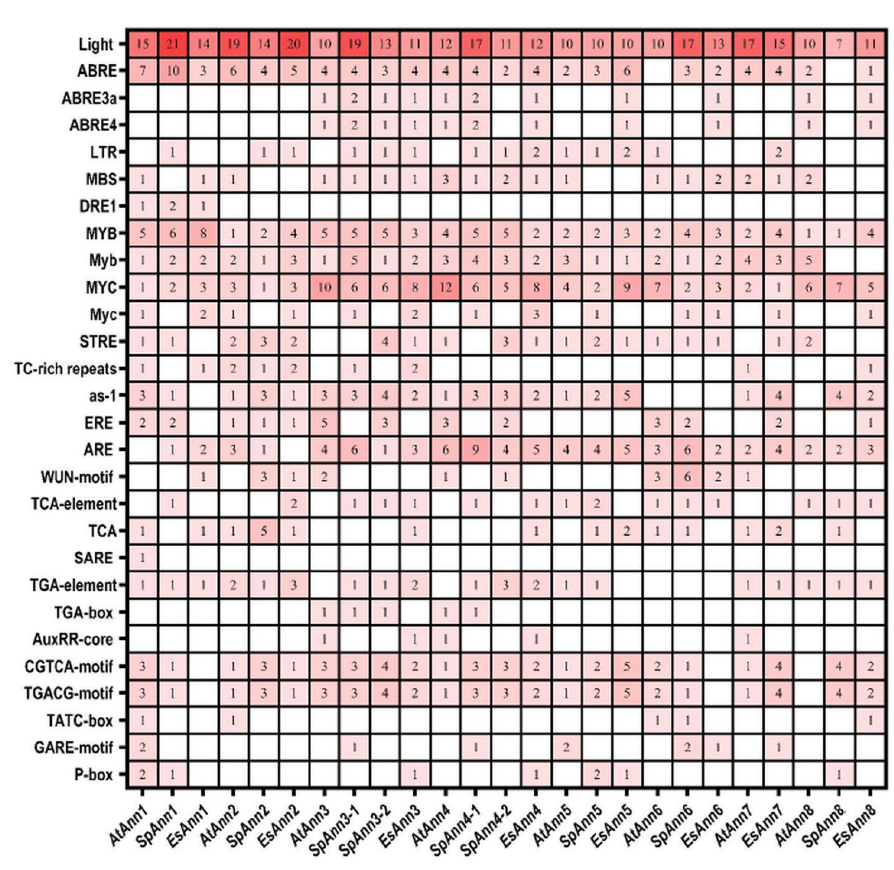
Fig 5. The identified cis-acting elements in Ann gene family promoters in A . thaliana , E . salsugineum and S . parvula .